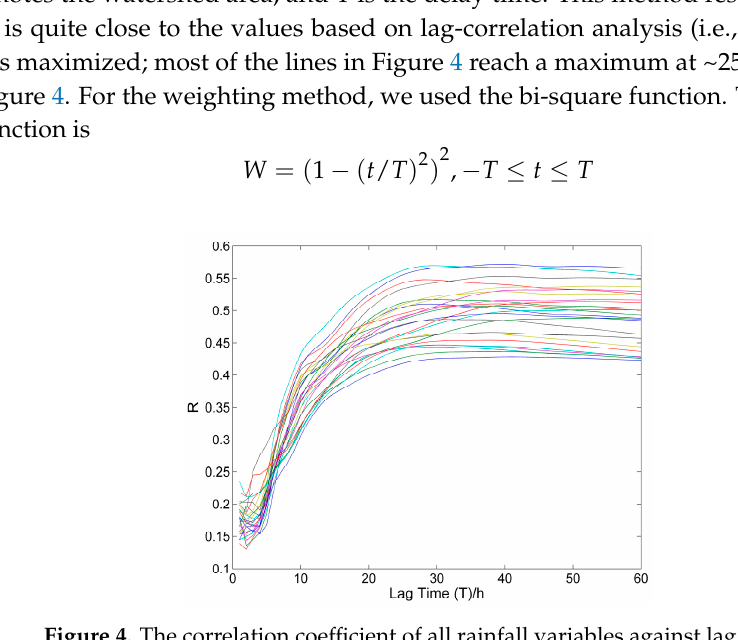
Figure 4. The correlation coefficient of all rainfall variables against lag time. T and W refer to the delay time at the maximum weight and the weight value, respectively, and